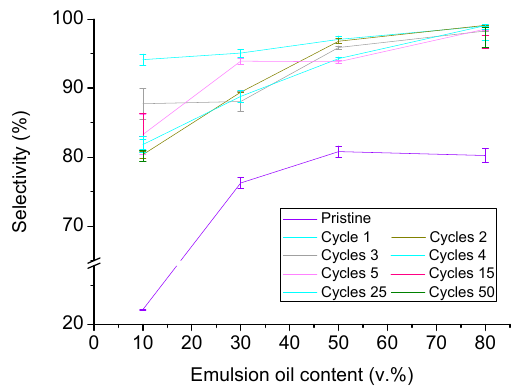
Figure 4. Oil absorption selectivity of PUT foams from stable water-in-oil emulsions up to 50 absorption/washing cycles.